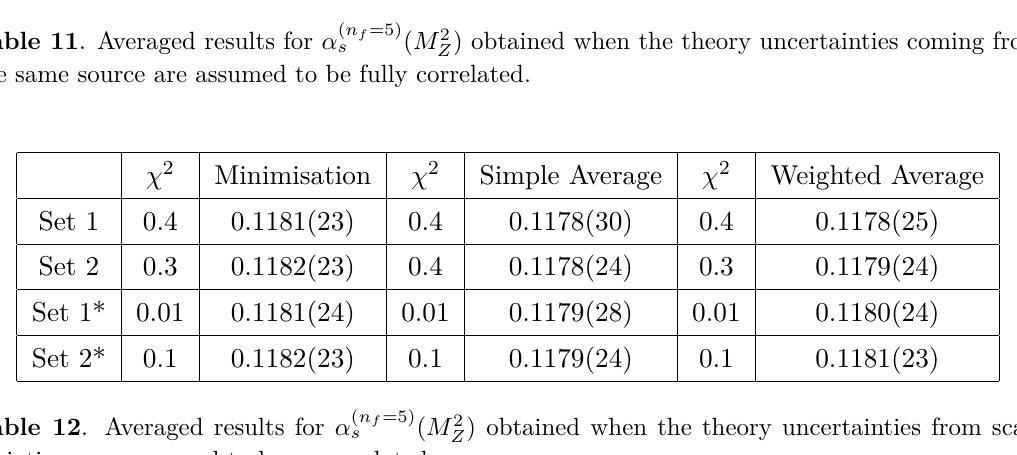
) obtained when the theory uncertainties from scale Z